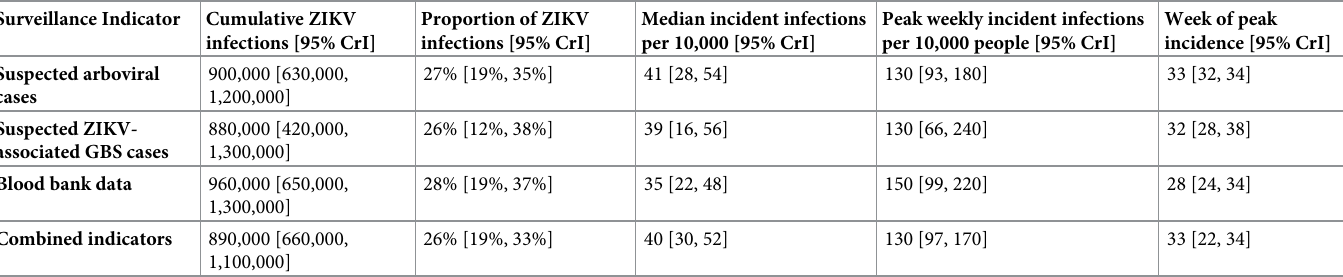
Table 1. Estimated Zika virus infections and 95% credible intervals (CrI) using three surveillance indicators.